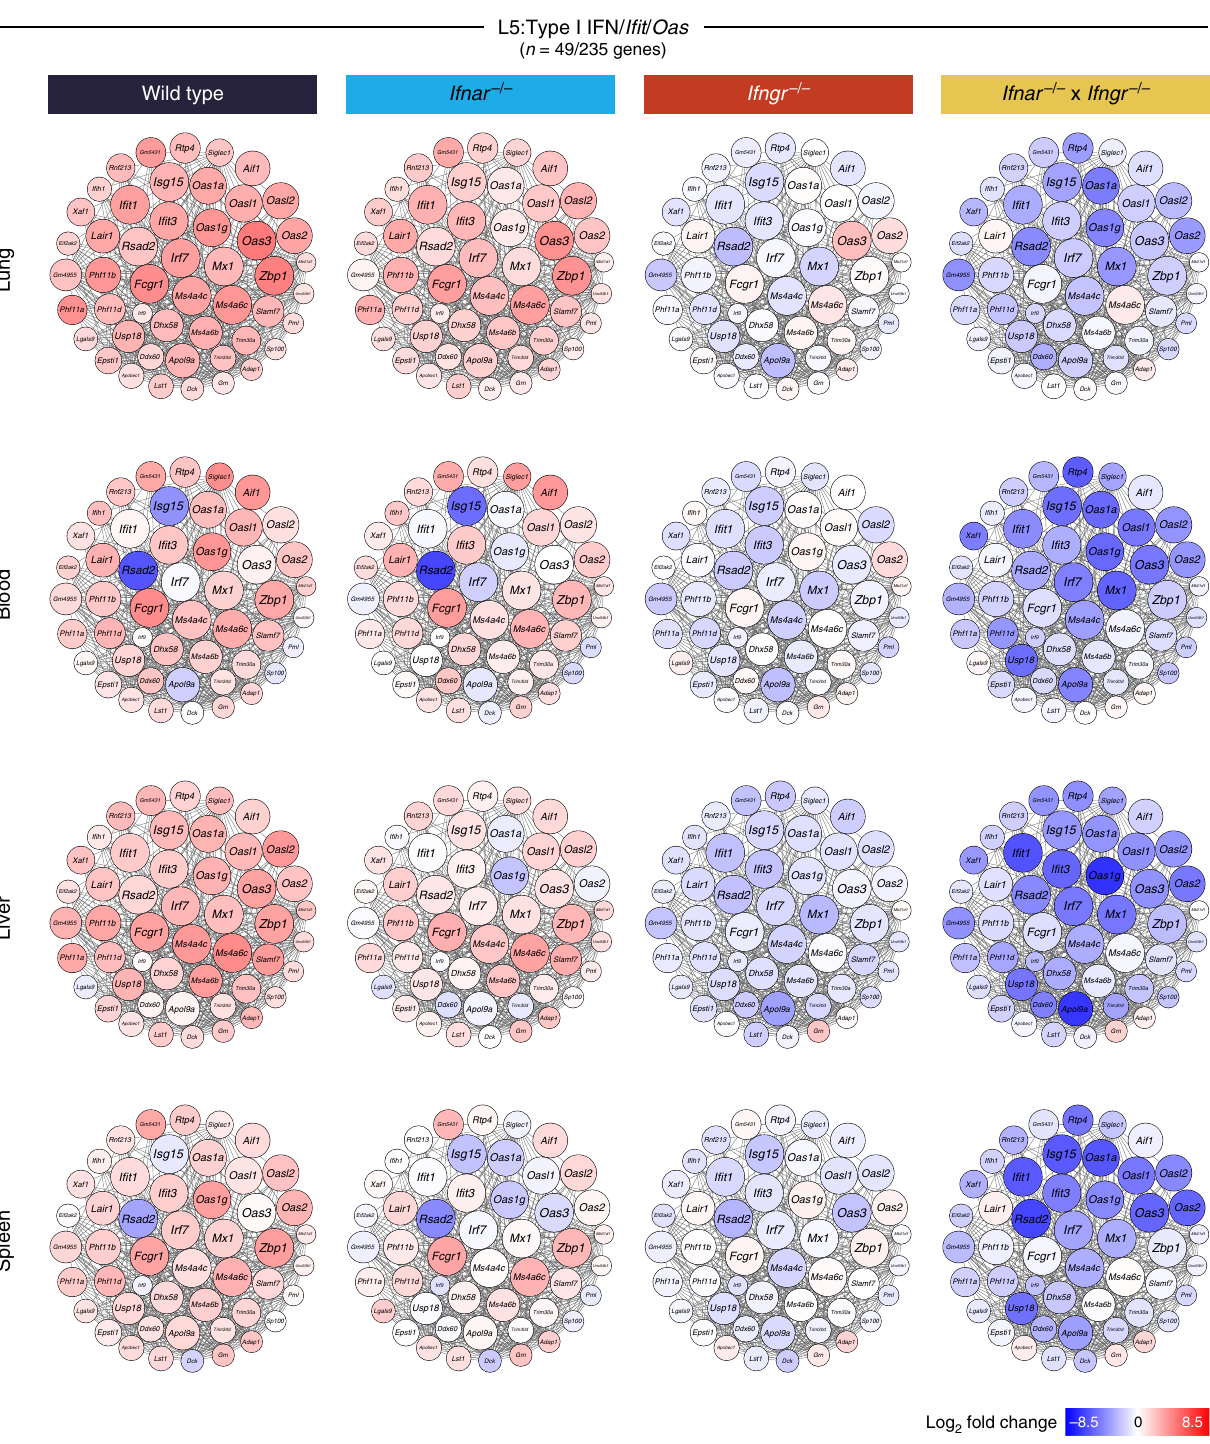
Fig. 7 Type I and/or II IFN signaling regulates the expression of genes within the lung Type I IFN// I fi t / Oas (L5) module following T. gondii infection. Gene networks depicting the “ hub ” genes in the lung L5 module representing genes with high intramodular connectivity, i.e., genes most connected with all other genes within the module. Each gene is represented as a circular node with edges representing correlation between the gene expression pro fi les of the two respective genes. Color of the node represents log 2 foldchange of the gene for Wild type or IFN receptor knockout T. gondii infected mice compared to Wild type controls, across lung, blood, liver, and